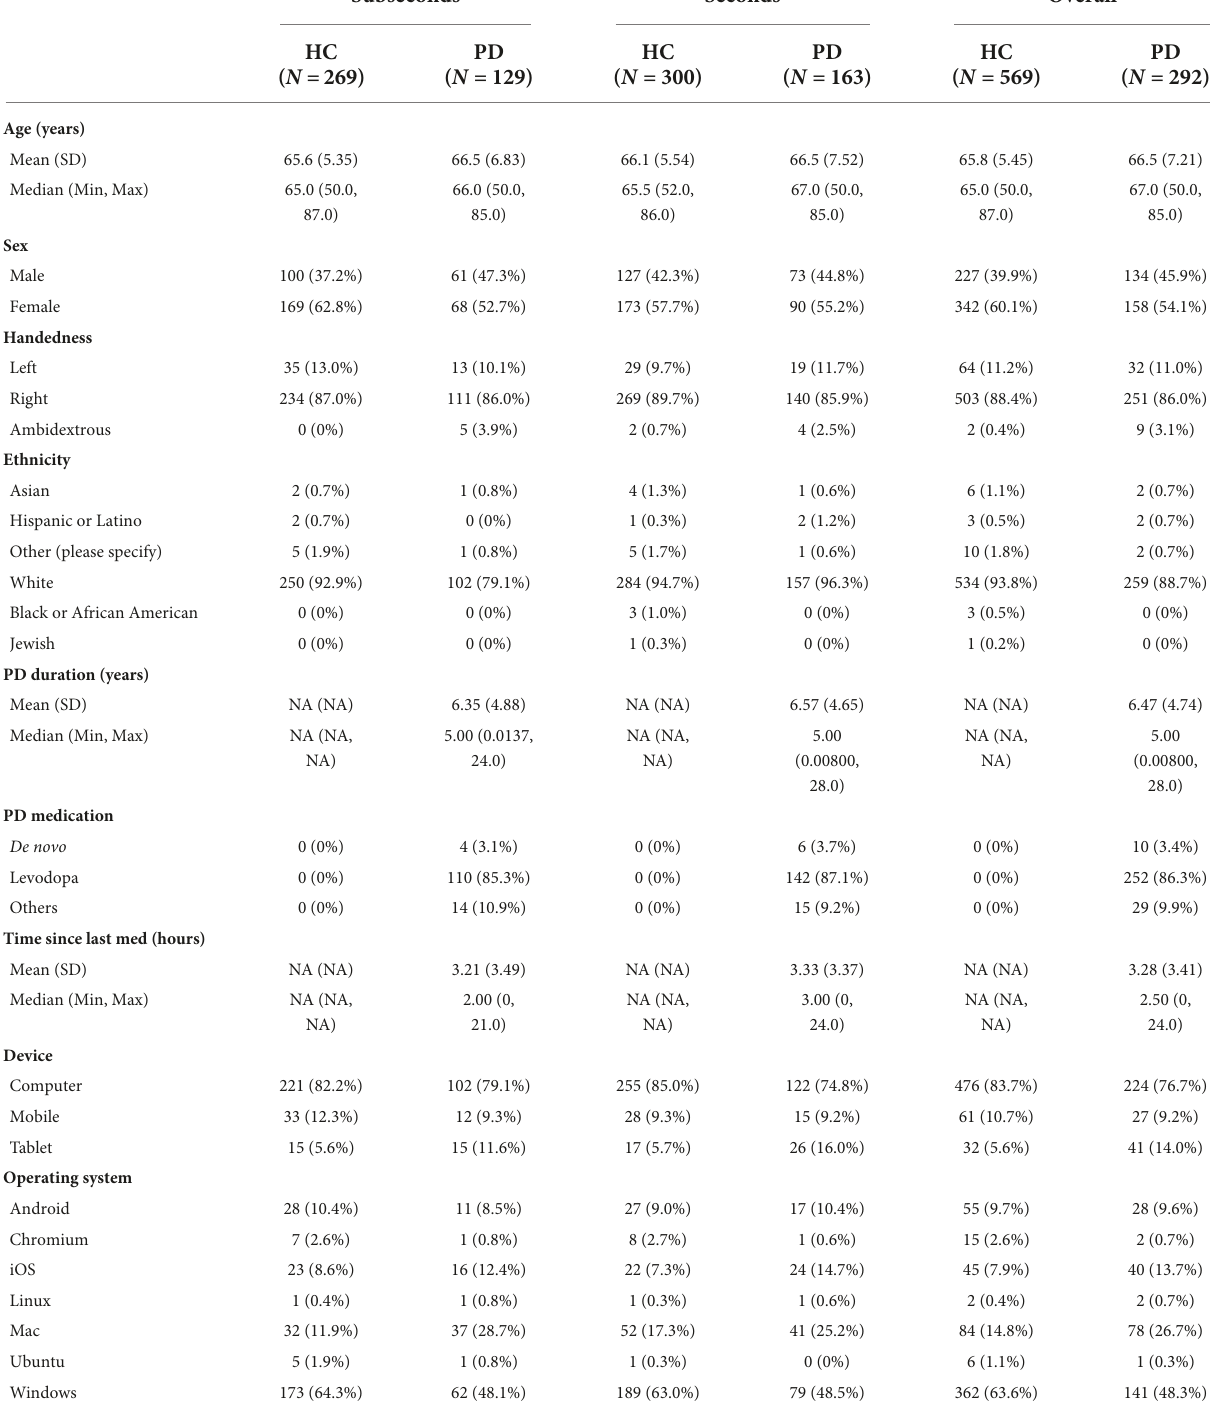
TABLE 1 Demographics table of Parkinson’s disease (PD) group and healthy control (HC) group performing the seconds or subseconds